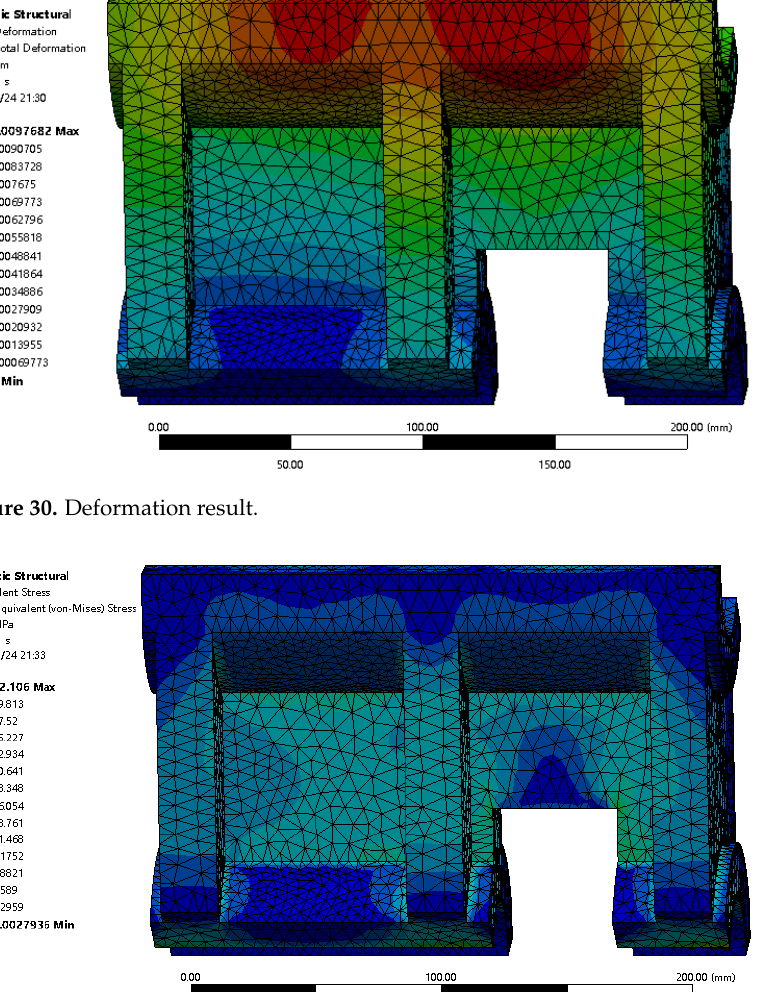
Figure 29. Grid division.